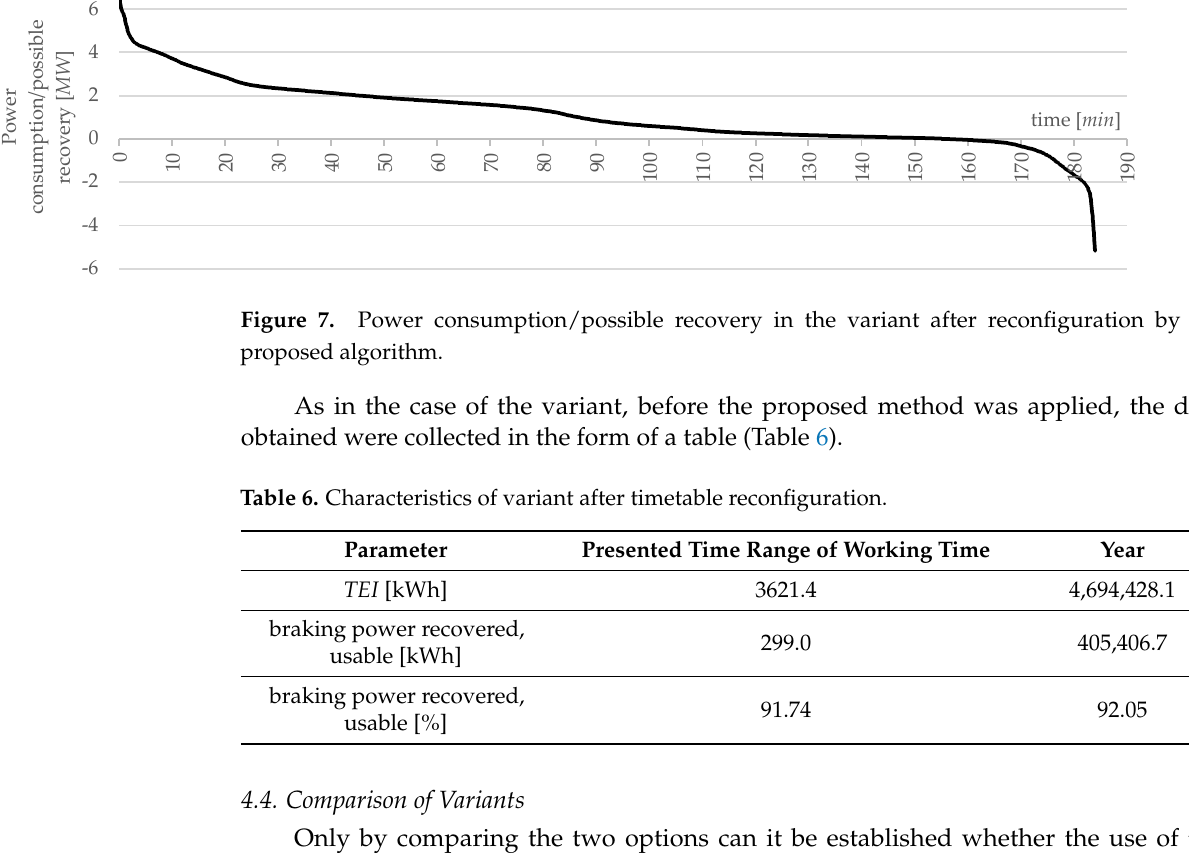
Table 7. Comparison of the variants before and after reconfiguration by the proposed method.